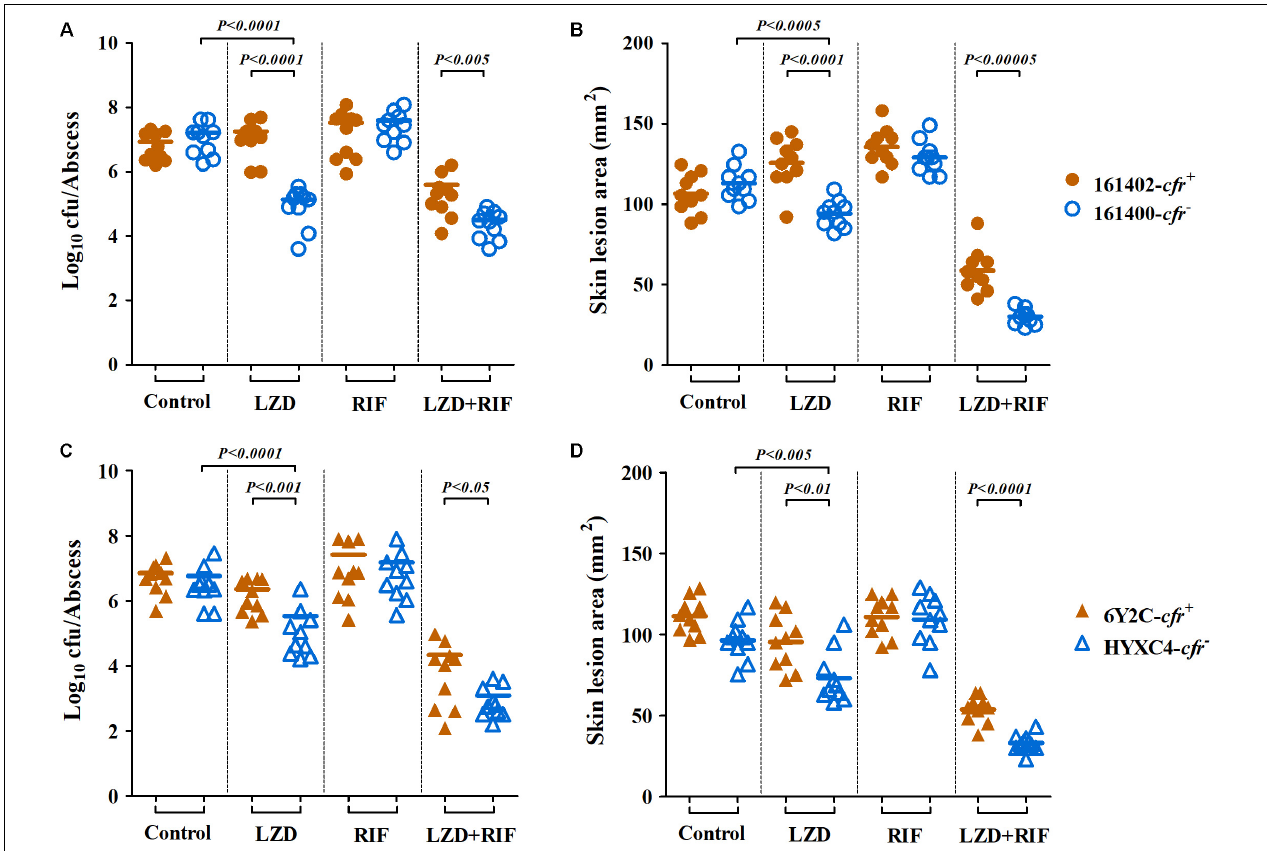
FIGURE 3 | Therapeutic efficacy of linezolid (LZD; 100 mg/kg twice daily) or rifampicin (RIF; 5 mg/kg twice daily) alone and in combination in a murine SSSI model due to cfr -positive (161402 and 6Y2C) and -negative (161400 and HYXC4) MRSA strains. Each dot represents MRSA density in each skin abscess (A,C) or the area of each skin lesion (B,D) , and the horizontal lines represent the means of observations from groups of five mice (two abscesses per